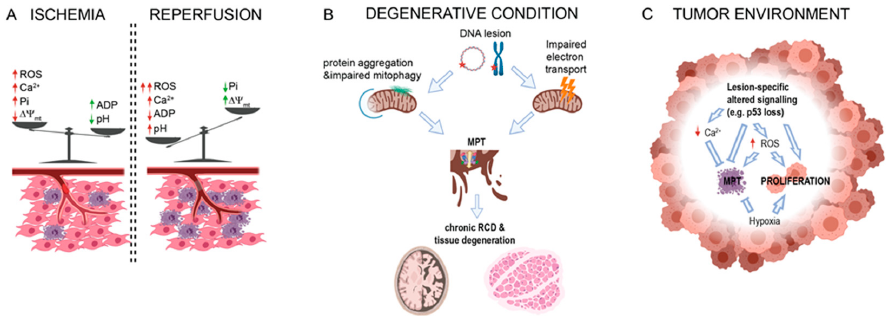
Figure 2. MPT alterations in human diseases. ( A ) Effect of ischemia and reperfusion in levels of MPT-regulating factor in insurgence of RCD (purple cells). ( B ) Schematic representation of the effect of mutations in mitochondrial or nuclear DNA (represented by circular DNA or chromosome, respectively) in human diseases characterized by degeneration of neuronal or muscular tissue. ( C ) Representation of major alterations in MPT regulators detected in tumor microenvironment. Nevertheless, under this condition, Ca 2+ overload may induce MPT-independent cell death as a result of the excessive activation of Ca 2+ -dependent enzymes such as phospholipases, proteases, and endonucleases [73,74]. Noticeably, during myocardial infarction, the activation of calpains, Ca 2+ - dependent cysteine proteases, results in myofibril disruption, thus promoting hypercontracture in the heart, which consists of sustained shortening and stiffening of the myocardium [75,76]. 2.2. Role of MPT in Reperfusion Injury The situation dramatically changes during tissue reperfusion. Indeed, the restoration of pO 2 recovers respiration, ATP synthesis, and the activity of plasma membrane pumps, which re- equilibrate intracellular pH. As a result, the inhibition of MPT by ADP and protons is removed, lowering the threshold for PTPC opening. In addition, reperfusion stimulates ROS production by multiple sources [77]. At the mitochondrial level, succinate is observed to accumulate in the mitochondrial matrix during ischemia and it was proposed to stimulate ROS production from complex I through reverse electron transport (RET), at the time of reperfusion [78]. Other pieces of evidence suggest that ETC conditions are not favorable for RET at the beginning of reperfusion, and that a burst of ROS production only occurs after a first wave of MPT. Besides mitochondria, reperfusion induces ROS via other enzymes including (but not limited to) xanthine oxidase, NADPH oxidase, and nitric oxide synthase [77]. These are believed to further stimulate ROS generation in the mitochondria, forming a vicious cycle and making mitochondria de facto the largest ROS source during reperfusion [79,80]. The elevated superoxide anion (O 2 − ) reacts with nitric oxide (NO), producing the highly reactive peroxynitrite. This leads to a reduction in the availability of NO (which is a potent vasodilator) and causes the accumulation of neutrophils [77]. Furthermore, oxidative damage causes lipid peroxidation, DNA damage, and enzyme denaturation and activates the innate anti-inflammatory response, aggravating reperfusion injury (RI) [81]. The occurrence of MPT during the reperfusion phase was demonstrated by the experiments of Griffith and Halestrap in 1995. They showed that mitochondrial accumulation of radioactive deoxy glucose (hot-dog), which can pass through the IMM only during MPT, did not occur in isolated hearts undergoing ischemia, but was significantly induced (and inhibitable by CsA) during reperfusion [82]. In the past decade, several in vitro and in vivo studies have confirmed the involvement of MPT in ischemia/RI [83]. The administration of CsA (as well as its analog FK506) has been shown to protect against ischemia/RI in multiple animal models and in multiple tissues, including cardiac and skeletal muscle, brain, kidney, liver, lungs, and testis [84–89]. Ppif -KO mice are significantly protected from ischemia/RI in both cardiac muscle and the brain, in terms of both tissue function and survival rates [31,32,90]. In addition to CypD manipulation, genetic interference in mechanisms of Ca 2+ homeostasis